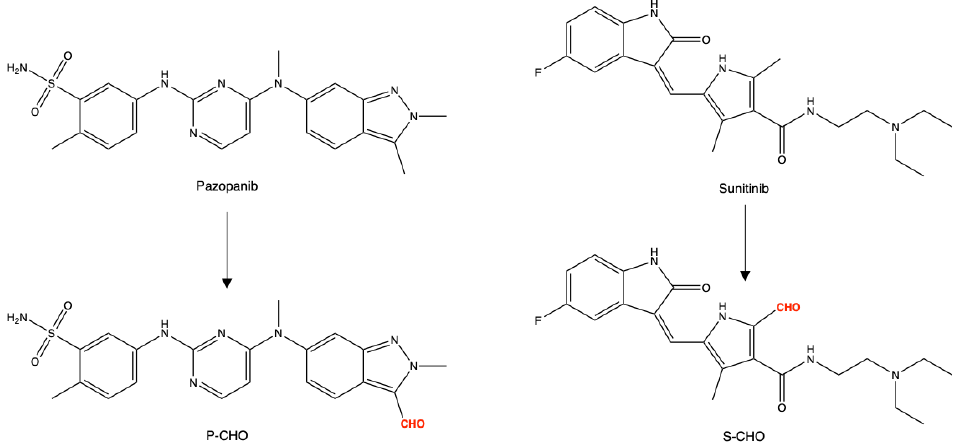
Figure 1. Chemical structures of pazopanib, sunitinib, and aldehyde derivatives (P-CHO and S-CHO, respectively).